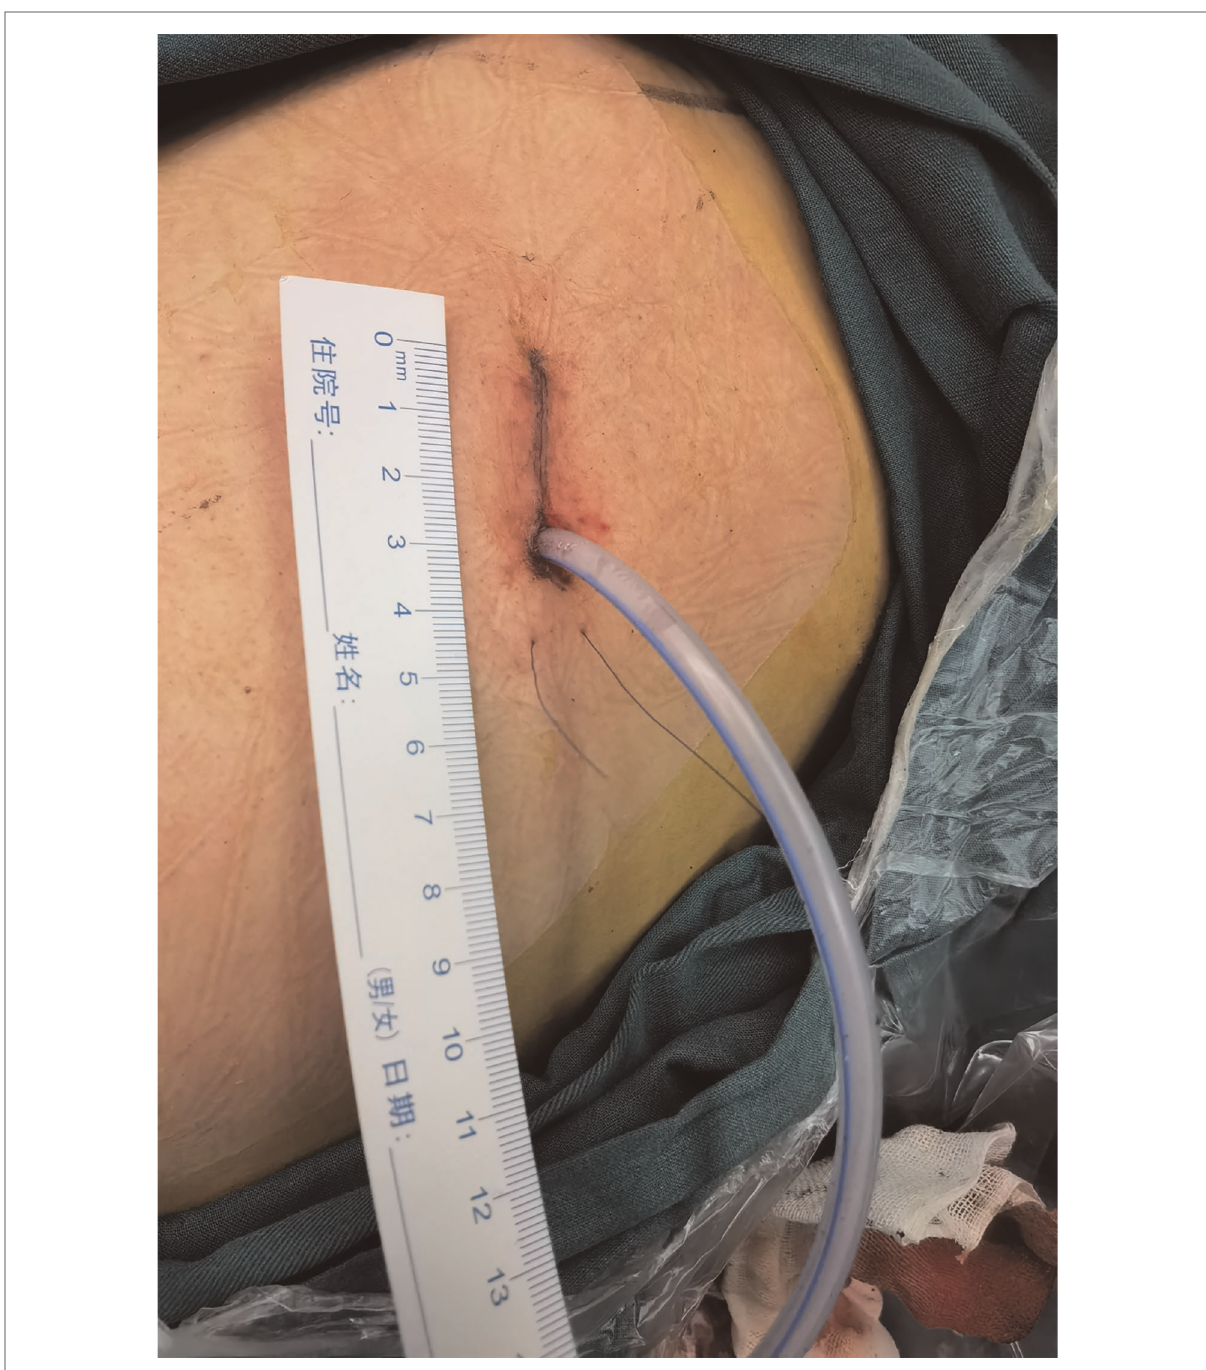
FIGURE 6 Placement of drainage tube, incision length and cosmetic result after